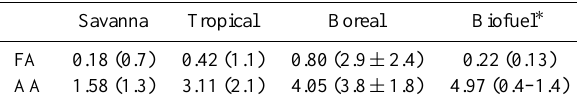
Table 1. Biomass burning emission factors for FA and AA (in g per kg of dry matter, Yokelson personal communication and Akagi et al. (2010)). Emission factors from Andreae and Merlet (2001) are indicated in